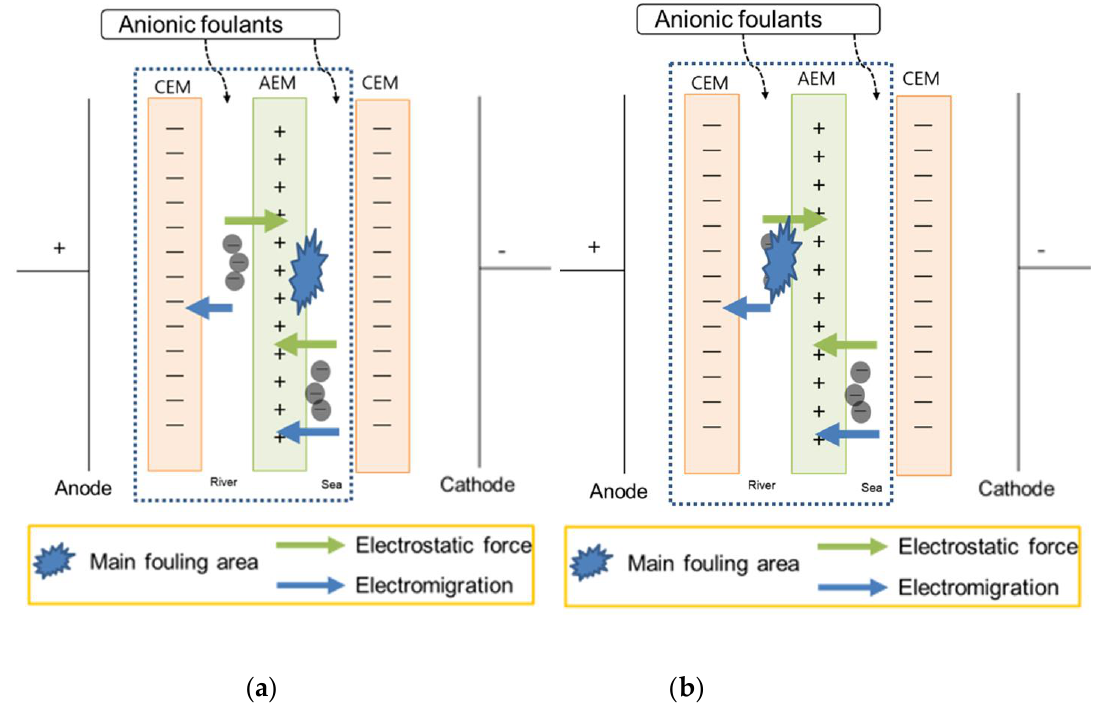
Figure 4. Illustration of showing ( a ) the hypothesis and ( b ) the experimental result of the RED system with only one cell pair (the part within the dashed square) supplying seawater and river containing anionic foulants.